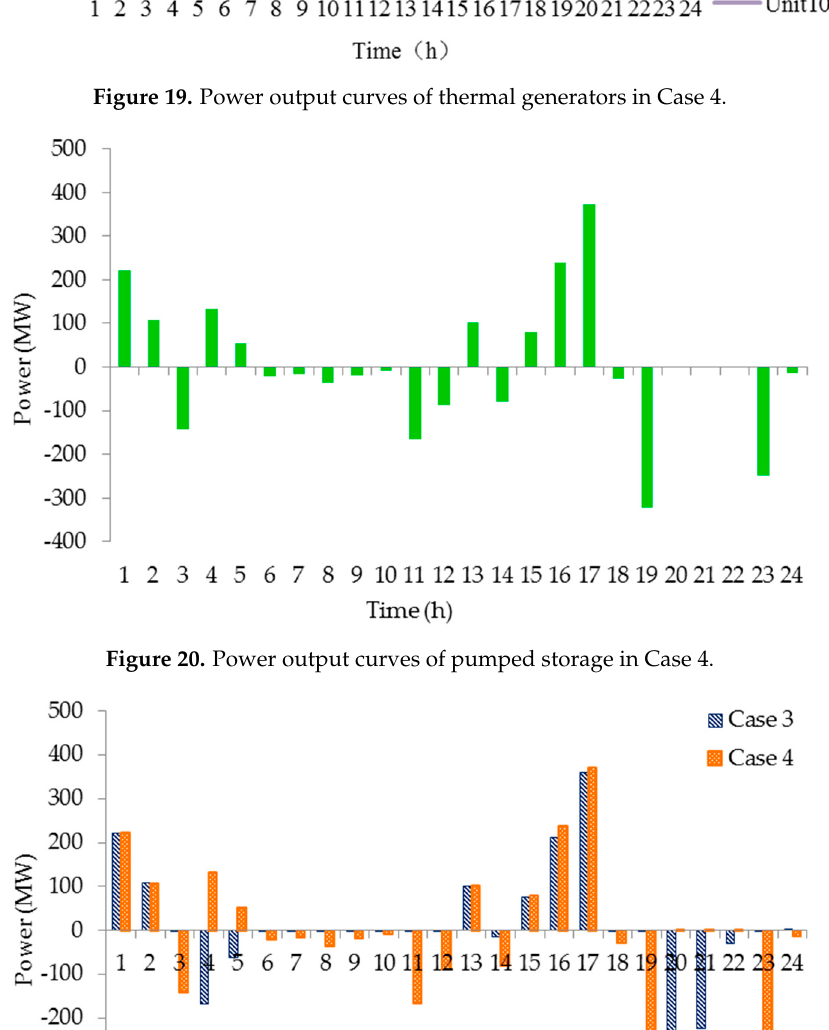
Table 4. Results comparison of Case 1 and Case 2 Parameters